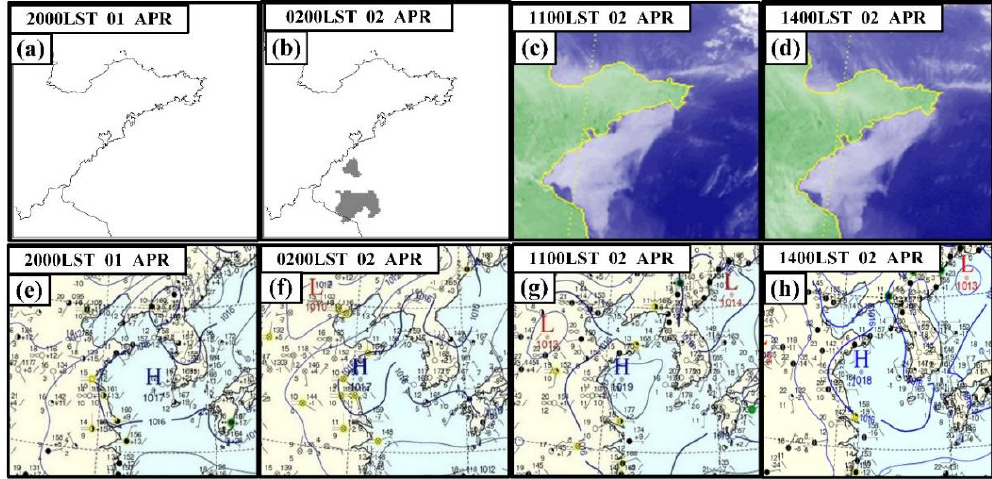
Figure 3. The retrieved sea fog ( a , b ) and Multifunctional Transport Satellite (MTSAT) visible satellite images ( c , d ), and Korea Meteorological Administration (KMA) surface synoptic charts ( e – h ) from 2000 LST 1 April to 1400 LST 2 April 2014.